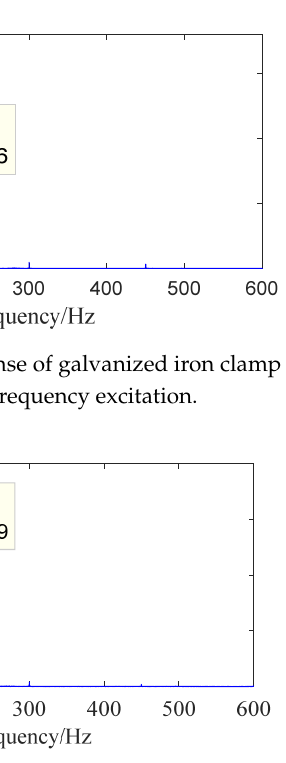
Figure 11. Vibration response of 304 stainless steel clamp with a 200- μ m-thick hard coating of 8% Y 2 O 3 -Z r O 2 under 150 Hz fixed-frequency excitation.